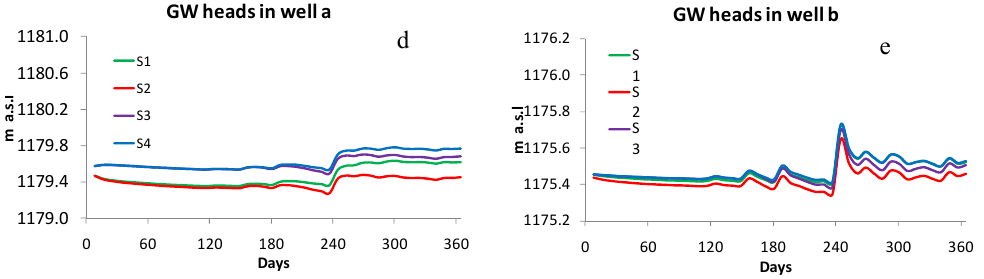
Figure 12. Simulated groundwater discharge to the Bulang River ( a ); and the calculated groundwater heads in well Blh ( b ); eco_site ( c ); well a ( d );and well b ( e ) for four land use scenarios.